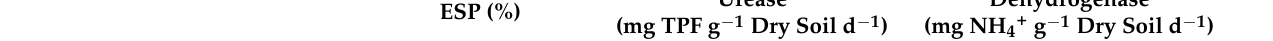
Table 1. Exchangeable sodium percentage (ESP%), urease, and dehydrogenase activity in soil after treating quinoa plants grown in the presence of different water regimes with phosphogypsum, plant growth-promoting rhizobacteria, or